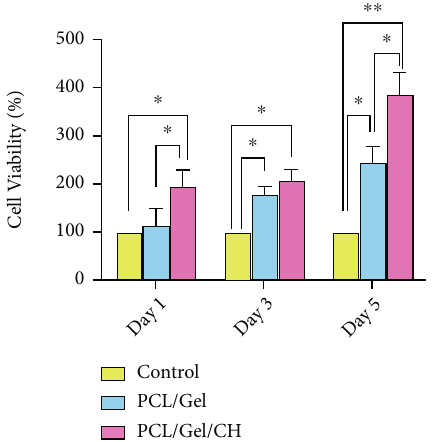
Figure 5: The viability of DPSCs seeded without sca ff olds (control) and on the PCL/Gel with and without Chrysin. ∗ p < 0 : 05 and ∗∗ p < 0 : 01 .